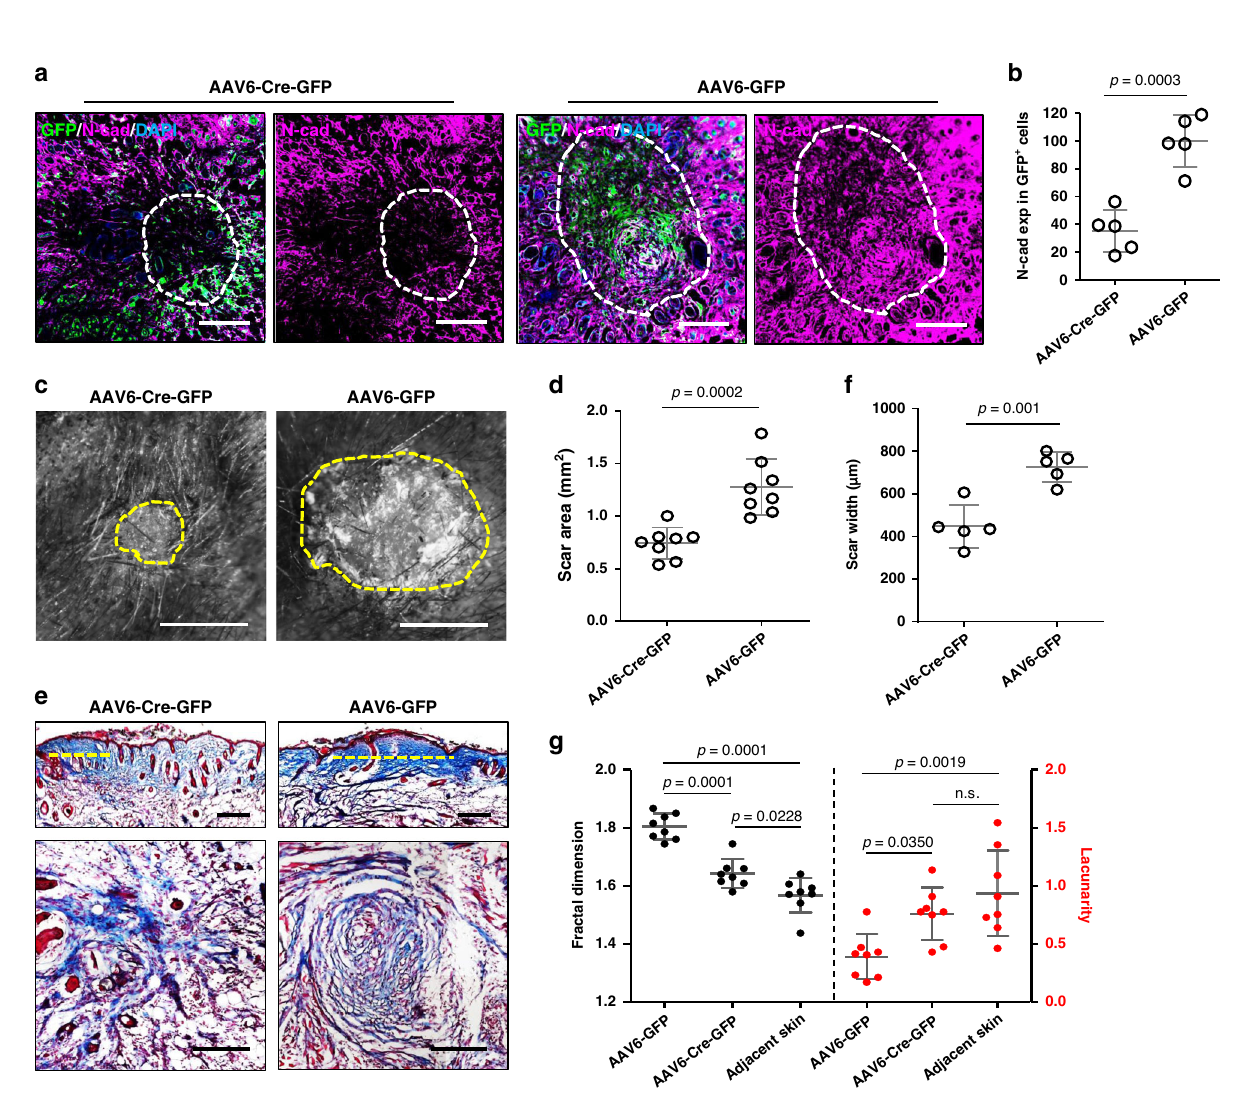
Fig. 5 N-cadherin is crucial for scar formation in vivo. N-cadherin was locally knockout around wounds on Ncad fl /l fl mice by injection of Cre-expressing AAV6-Cre-GFP virus. AAV6-GFP virus served as control. a Immunolabelling of N-cadherin on transverse cross-sections of harvested scars on 14-dpi. GFP indicates transduced cells. Dash lines outline the scar edges. b N-cadherin expression in GFP + cells based on immuno fl uorescence analysis. Data are normalised on the mean of N-cadherin expression in AAV6-GFP wounds. Mean± SD, n = 5, p = 0.0003, unpaired two-tailed t -test. c Stereomicroscopic images of AAV6-Cre-GFP and AAV6-GFP treated scars at 14-dpi. The yellow dash lines indicate the scar edge. d Quanti fi cation of scar area based on histomorphometric analysis. Mean ± SD, n = 8, p = 0.0002, unpaired two-tailed t -test. e Masson ’ s trichrome stained vertical (upper panel) and transverse (lower panel) sections from AAV6-Cre-GFP and AAV6-GFP treated scars. The dash lines indicate scar width. f Quanti fi cation of scar width based on histomorphometric analysis. Mean± SD, n = 5, p = 0.001, unpaired two-tailed t -test. g Fractal dimension and lacunarity analysis of AAV6-Cre-GFP and AAV6-GFP treated scars and adjacent normal skin. Mean± SD, one-way ANOVA Tukey ’ s test, n = 8, p values from multiple comparisons are shown in the graph. Scale bars: a , d = 200 µ m; b = 500 µ